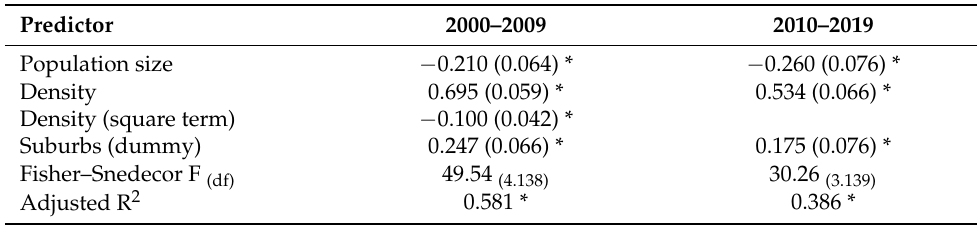
Table 2. Results of a forward stepwise regression analysis identifying the most relevant predictors of general fertility rates in urban, suburban, and rural districts of Greek prefectures ( n = 142); standard errors in parentheses; * p <